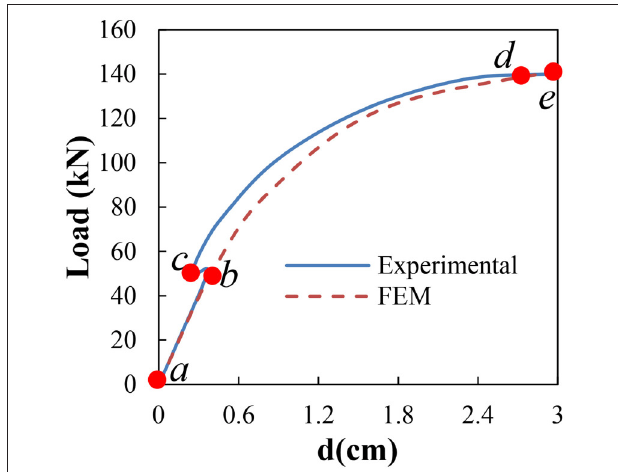
FIGURE 5 | Load vs. displacement